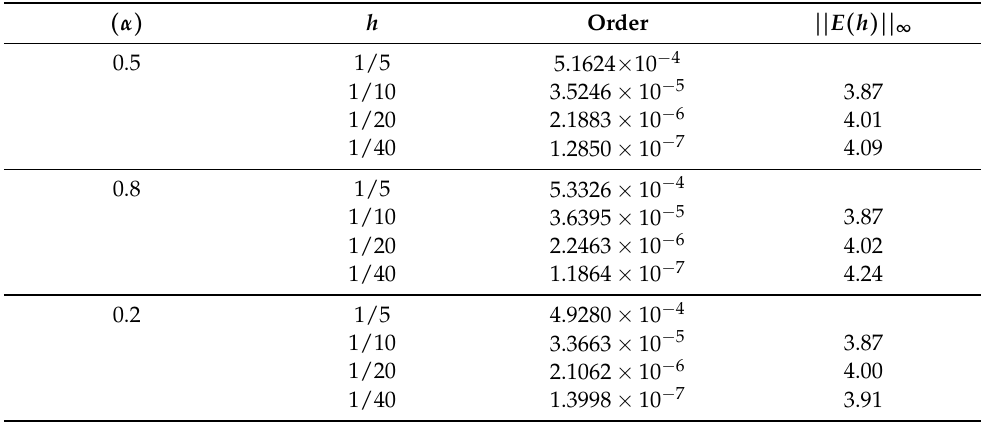
, α = β and θ = α 2 4000